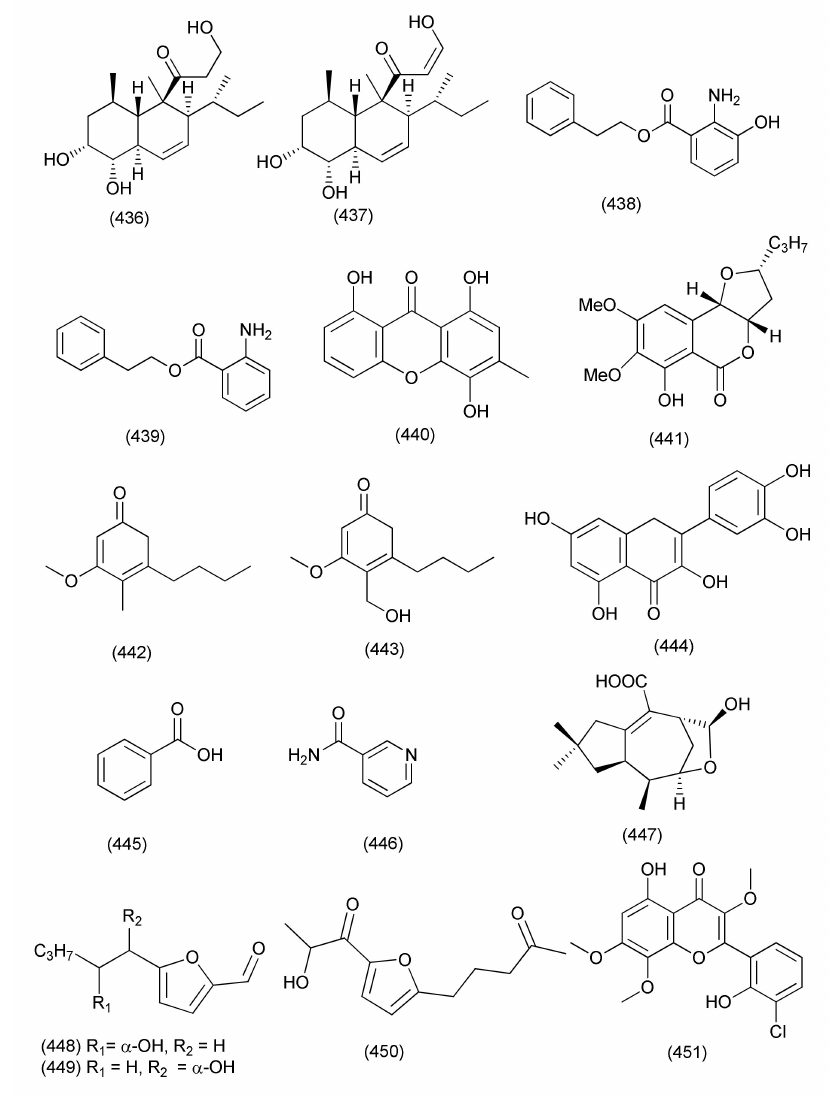
Figure 24. Structures of metabolites 436 – 443 isolated from Minor Anamorphic Ascomycetes, 444 – 450 from Basidiomycetes and 451 from